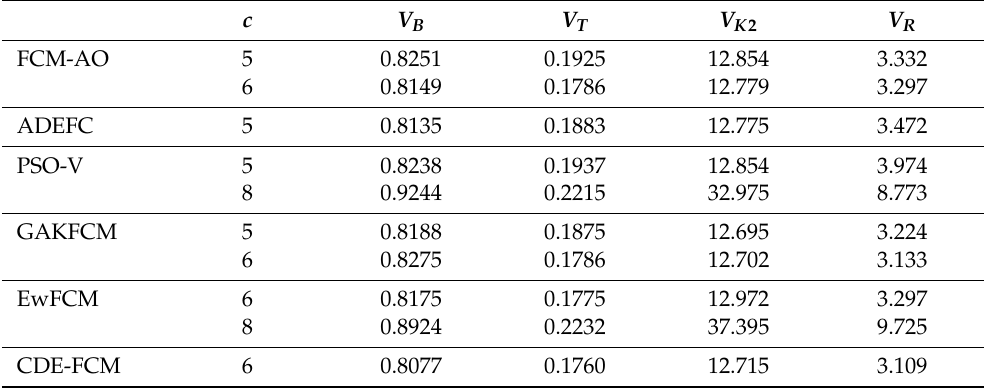
Table 6. Performance of algorithms on glass